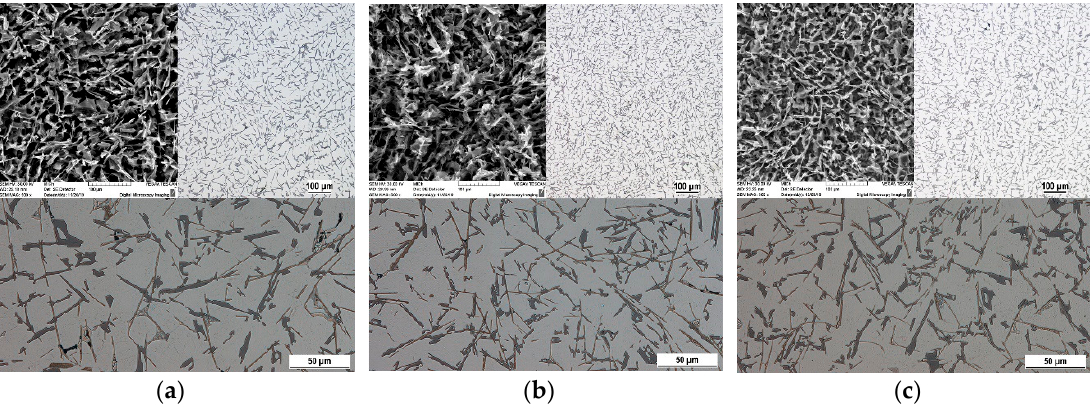
Figure 4. Microstructure of AlSi9Cu3 alloy depend on the ratio of returnable material in the batch after natural aging, SEM; ( a ) 20–80 alloy, ( b ) 50–50 alloy, ( c ) 90–10 alloy.